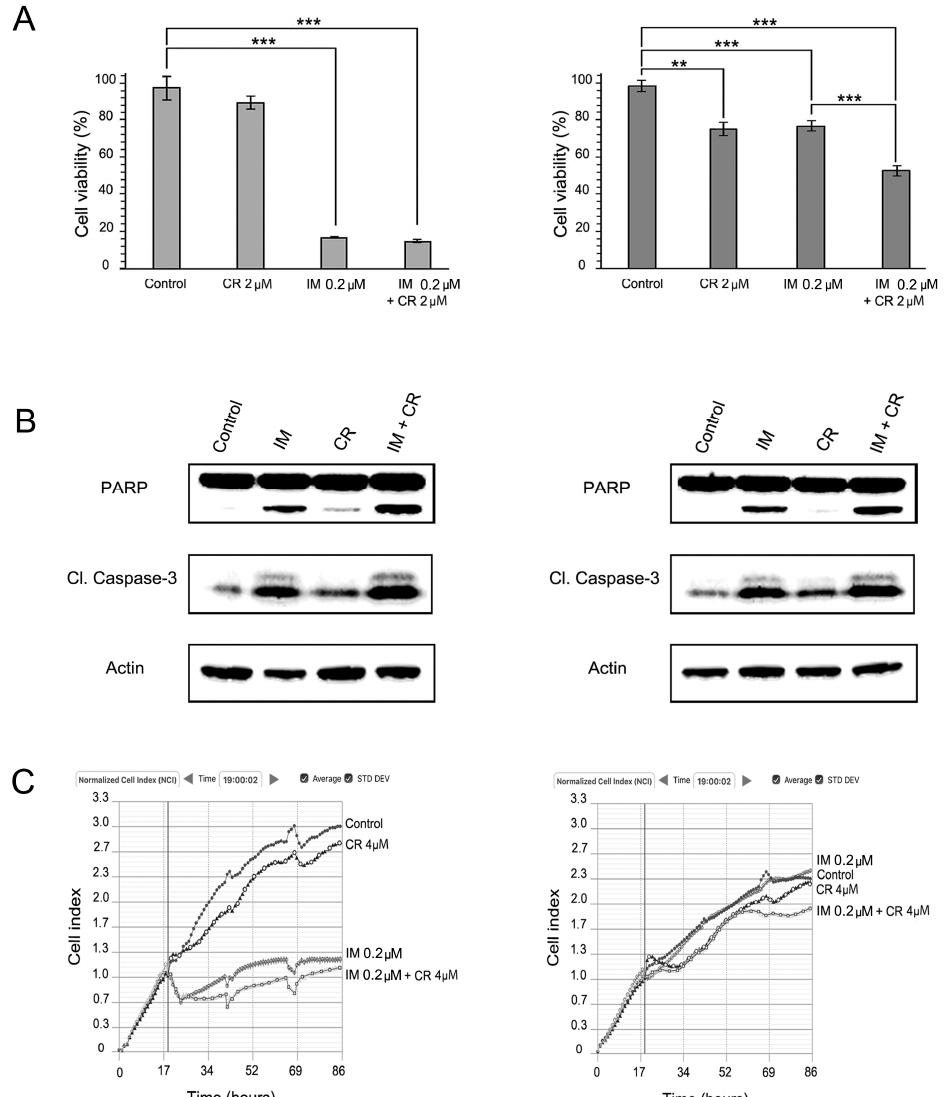
Figure 2. Crizotinib (CR) enhances cytotoxic effects of IM in GIST cells. ( A ) MTS-based viability assay of GIST T-1 and GIST T-1R cells. Treatment with DMSO (control), IM or crizotinib (CR) alone and in combination in GIST T-1 (left) and GIST T-1R (right) cells. Experiments are conducted in triplicates and represented as the mean ± SD. **: p ≤ 0.01; ***: p ≤ 0.001; ( B ) Immunoblot analysis for apoptosis markers (cleaved forms of PARP and caspase-3) in GIST cells after treatment with DMSO (control), IM, CR alone and in combination (e.g., IM + CR) for 72 h. Actin was used as a loading control; ( C ) Changes in growth kinetics of GIST T-1 (left) and GIST T-1R (right) cells treated with DMSO (control), IM or CR alone and in combination.